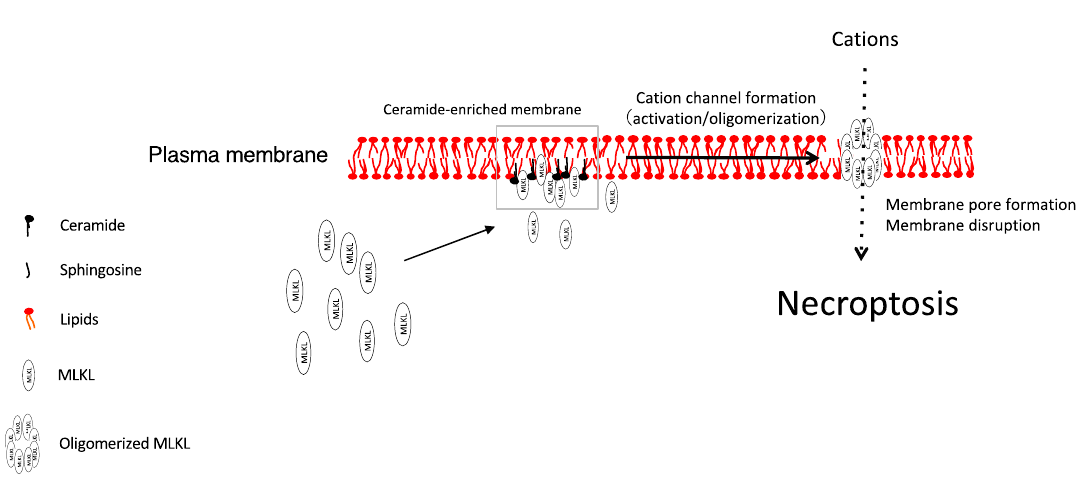
Figure 2. Proposed model for necroptosis induced by ceramide.